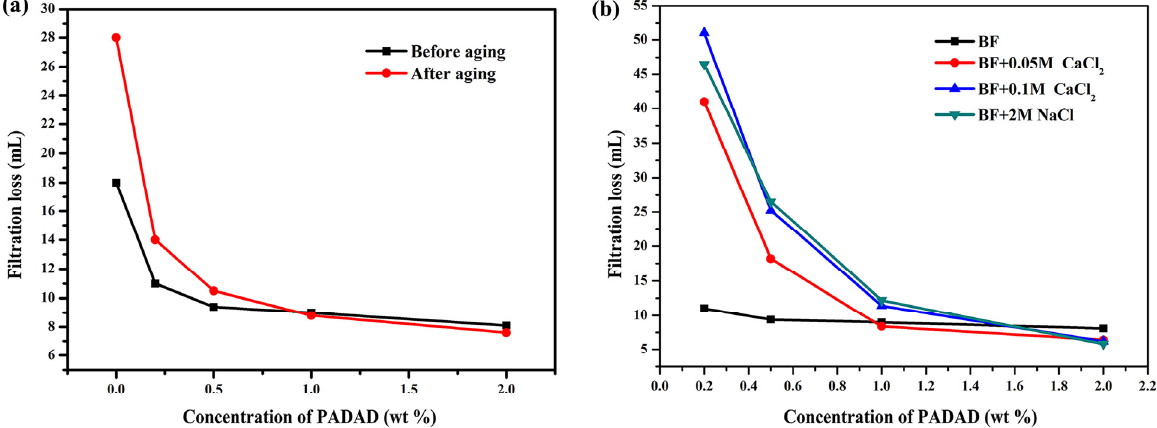
Figure 10. ( a ) The filtration loss (FL API ) of BF with different PADAD concentrations before and after aging at 160 °C for 16 h. ( b ) The filtration loss (FL API ) of BF with different PADAD concentrations in the presence of NaCl or CaCl 2 .